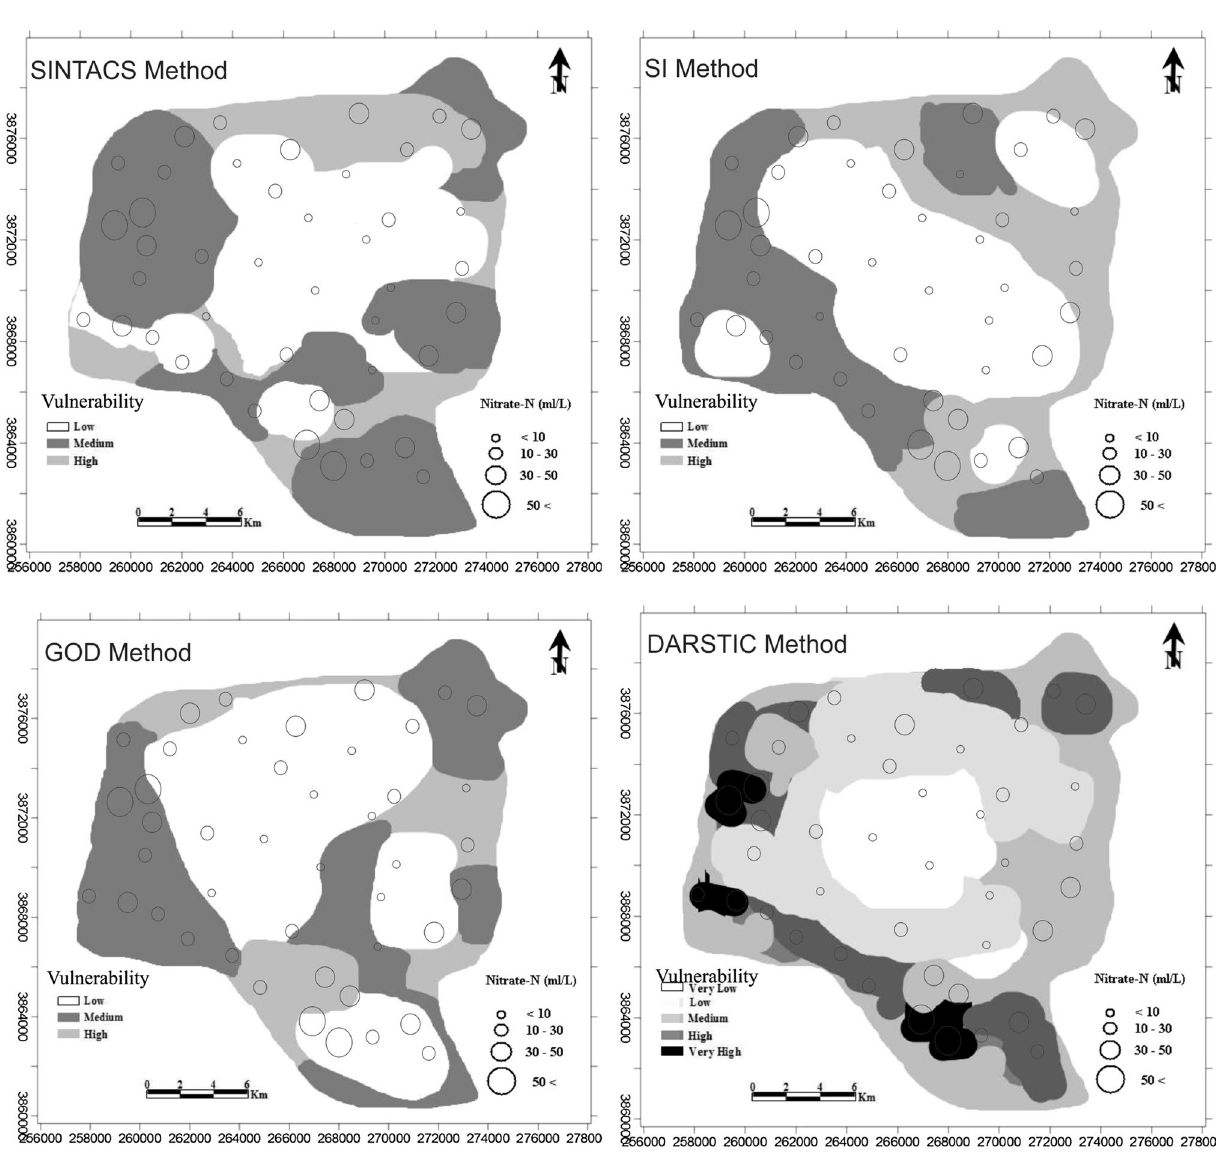
Fig. 7 The vulnerability maps using different methods along with the distribution of nitrate concentration in study area